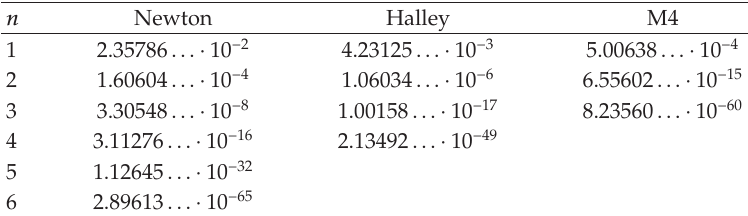
Table 3: Errors for the Newton, Halley, and M4